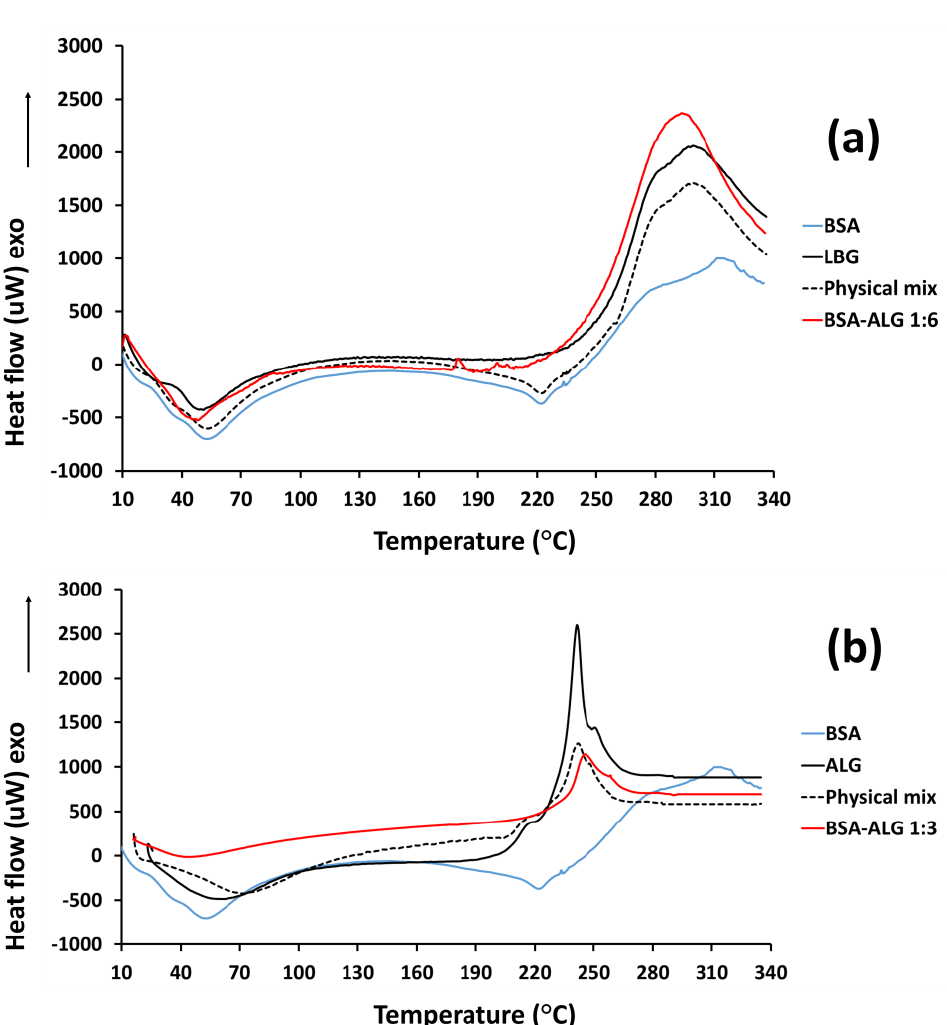
Figure 2. ( a ) DSC thermograms of the native BSA (blue line), LBG (black line), BSA–LBG physical mixture (dotted line), and BSA–LBG 1:6 conjugate (red line); ( b ) DSC thermograms of the native BSA (blue line), ALG (black line), BSA–ALG physical mixture (dotted line), and BSA–ALG 1:3 conjugate (red line).